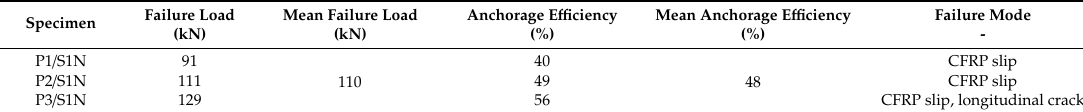
Figure 12. Load-displacement plots for all the specimens in the S1N series. Table 2. Test results of the specimens tested in S1N series. Table 3. Summary of the loads resulting in the partial slip of the specimens tested in S1N series.